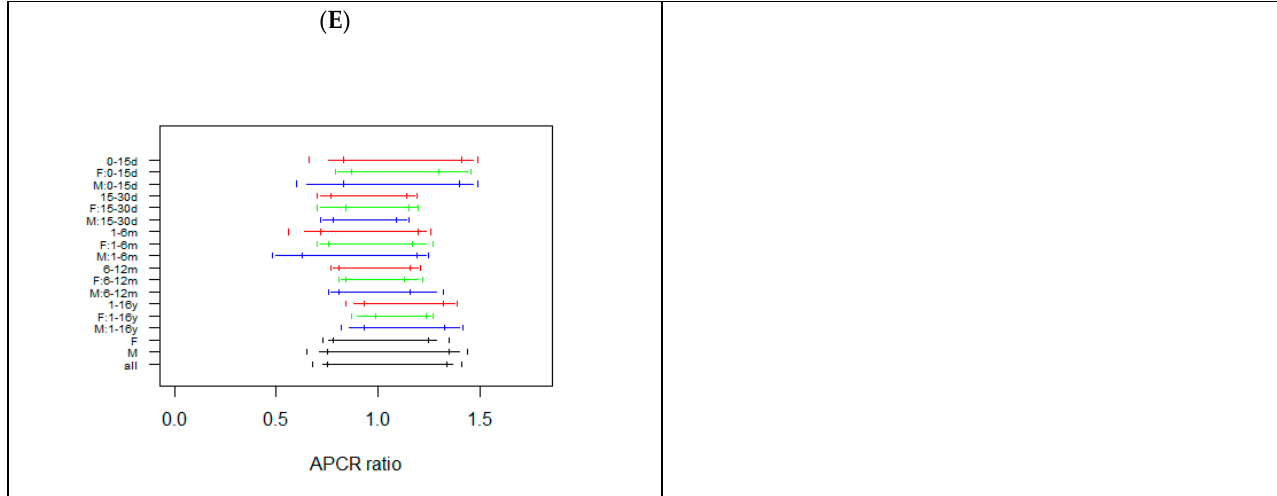
Figure 5. Reference intervals for VWF: Ag ( A ), VWF: RCO ( B ), PTT-LA ratio ( C ), DRVV Screening ratio ( D ), and APCR ratio ( E ) in the subjects subgrouped by sex and age. The horizontal segments represent the RIs, while the vertical segments indicate the limits of the 90% confidence interval of the RIs. For each class, RIs are reported combining males and females (red) or, respectively, only in females (green) or males (blue). The last three RIs were calculated without taking into account age, in females, males, or in the whole sample. d = days, m = months, y = years, F = females, M = males.